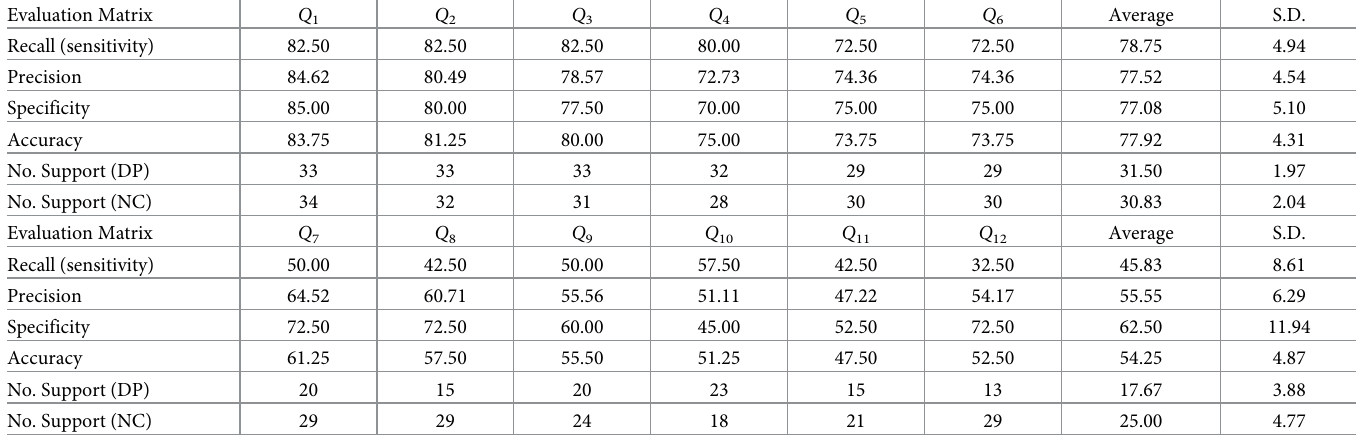
Table 3. Recall, precision, sensitivity, accuracy, and numbers of support (positive predicted) for each group of six questions of reviews of symptom ( Q 1 − Q 6 ) and six questions of describing emotional